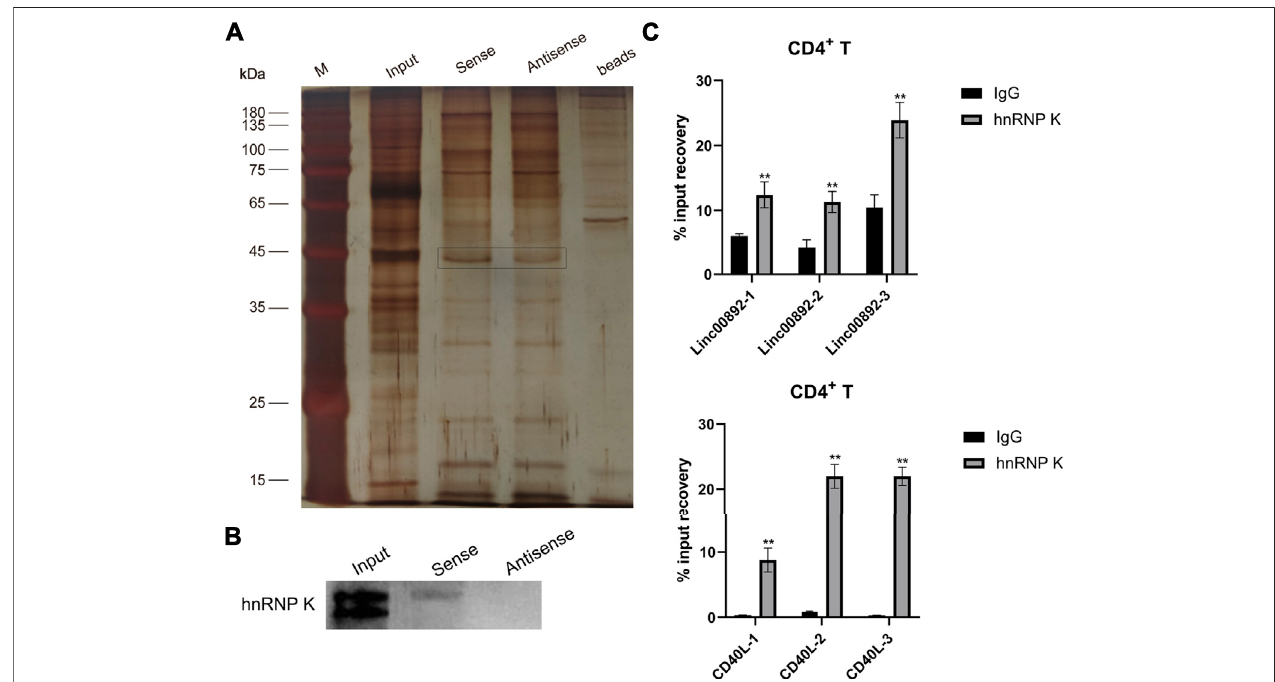
FIGURE 4 | LincRNA00892 mediates CD40L expression by targeting hnRNP K in primary CD4 + T cells. (A) RNA pulldown assay was used to identify the proteins interactedwithlincRNA00892.SilverstainingoftheproteinspulleddownbylincRNA00892. (B) TheexpressionofhnRNPKinthegelpulleddownbycontrol,sense,and anti-sense lincRNA00892 was con fi rmed by western blotting. (C) The interaction between hnRNP K and lincRNA00892 (up) and CD40L (down) was identi fi ed by RIP. IgG was used as the negative control. ** p < 0.01, * p < 0.05. The results are expressed as mean ± standard deviation. Student ’ s t-test was used for comparison of two